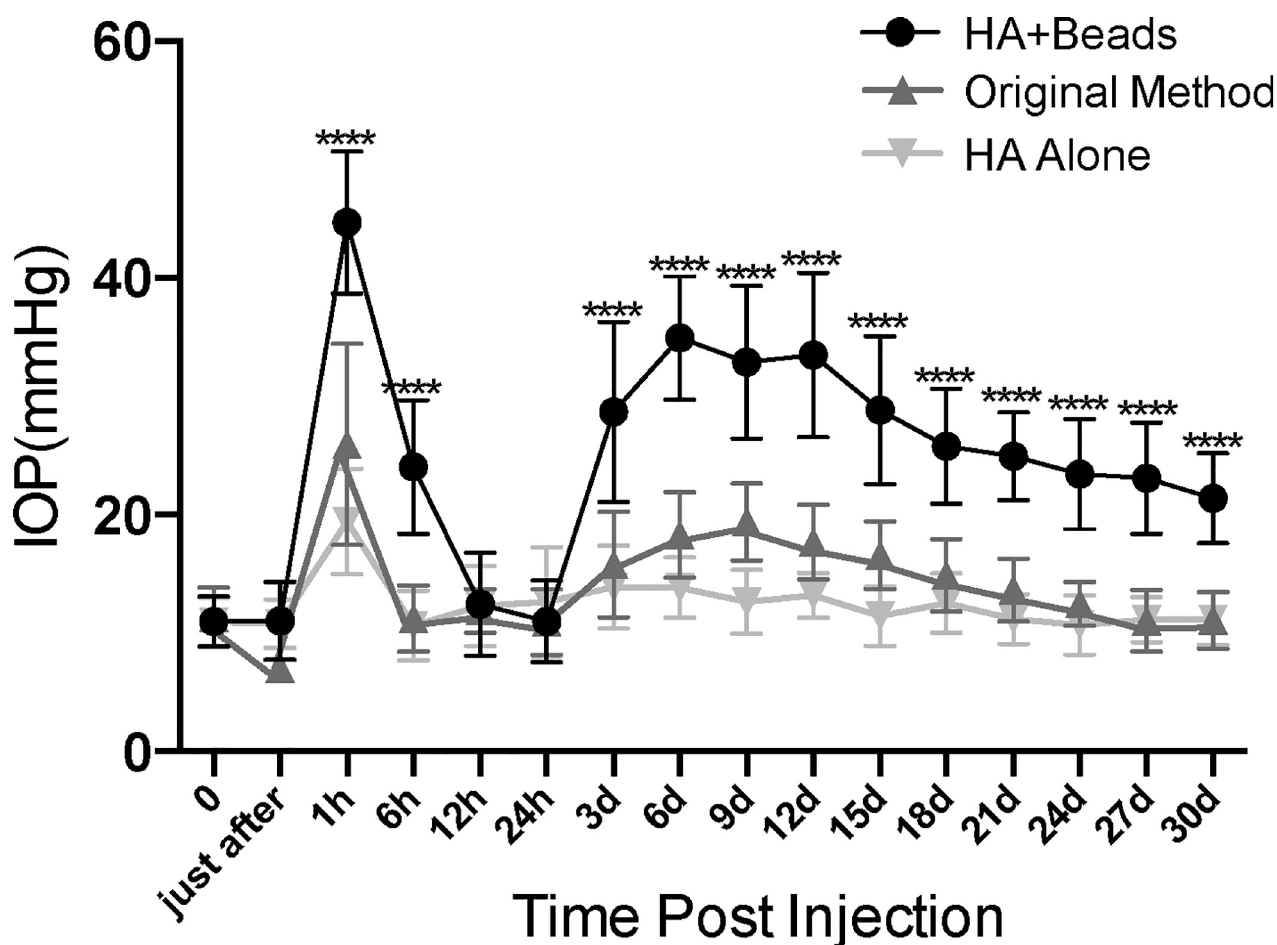
Fig 1. Assessment of IOP elevation after beads injection during the 4 week follow-up period. IOP levels temporarily rose within 20mmHg in the hyaluronic acid (HA) group (HA alone) (n = 13). 3 μ l injections of beads suspended in saline (Original Method group) induced a transient elevation of IOP after 1 hour, with a mean peak value of 25.92 ± 8.51 mmHg. When the IOP reached a second peak at 9 days after beads injection, the mean IOP of this second peak did not exceed 20mmHg (n = 13). In the group with 6 μ l injections of beads suspended in HA (HA+Beads group), IOP transiently rose to over 40 mmHg at 1 hour post-injection. Although IOP decreased to normal levels 1 day after injection, IOP increased again starting from day 3. IOP reached a second peak between day 6 and day 12. Sustained IOP elevation was observed during the follow-up period (n = 9). Multiple group comparison using ANOVA showed a significant IOP increase at almost all follow-up time points in the mixture (HA+Beads) group relative to the other groups. ���� p <